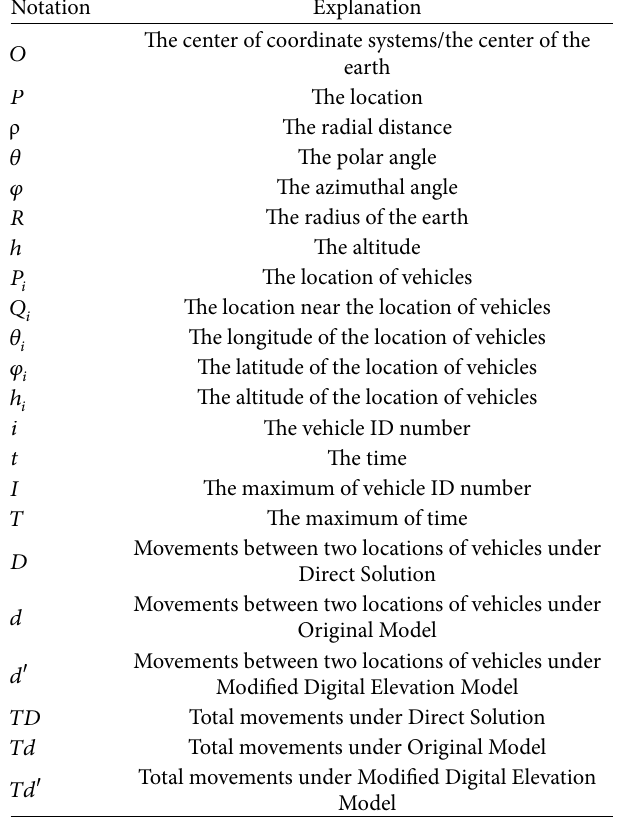
Table 7: Notations for